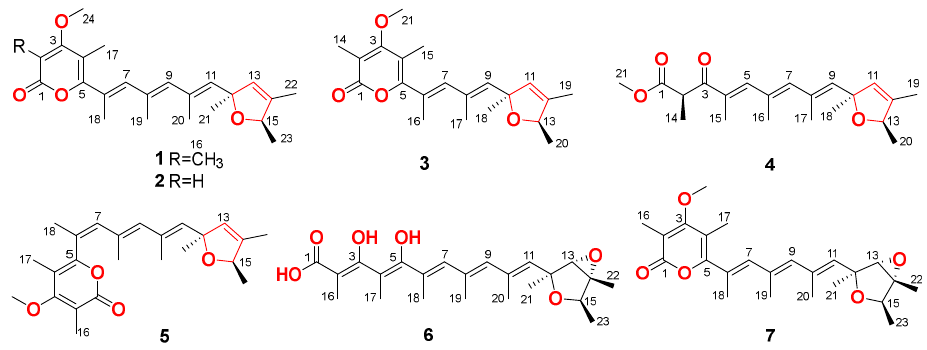
Figure 1. Chemical structures of compounds 1 – 7 .